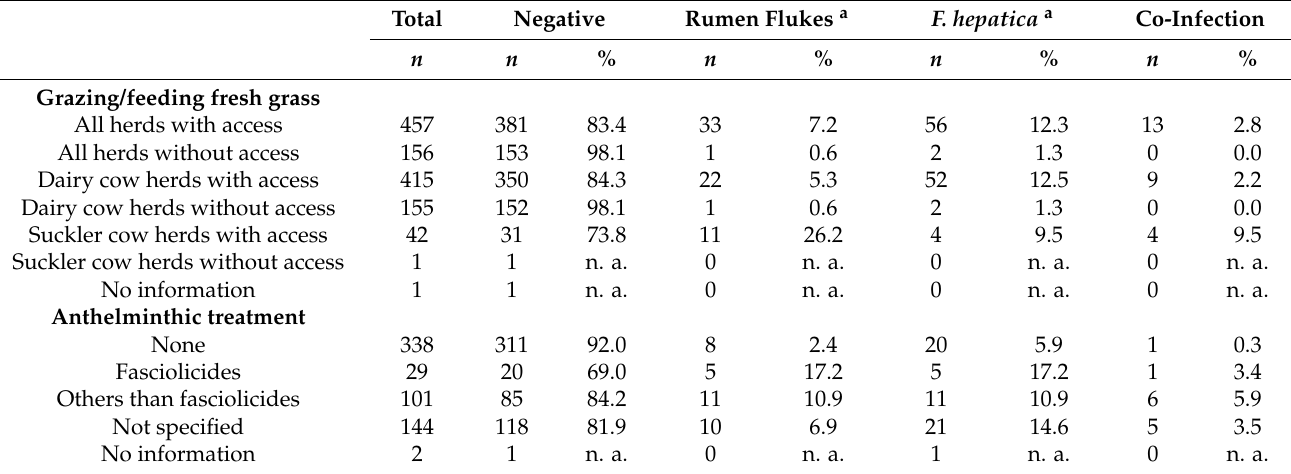
Table 4. Descriptive data on the occurrence of patent rumen fluke, F. hepatica and co-infections in German cattle farms ( n = 614) related to the management factors grazing/feeding fresh grass and anthelminthic treatment. Note that percent calculation was omitted if less than five farms (total values) were